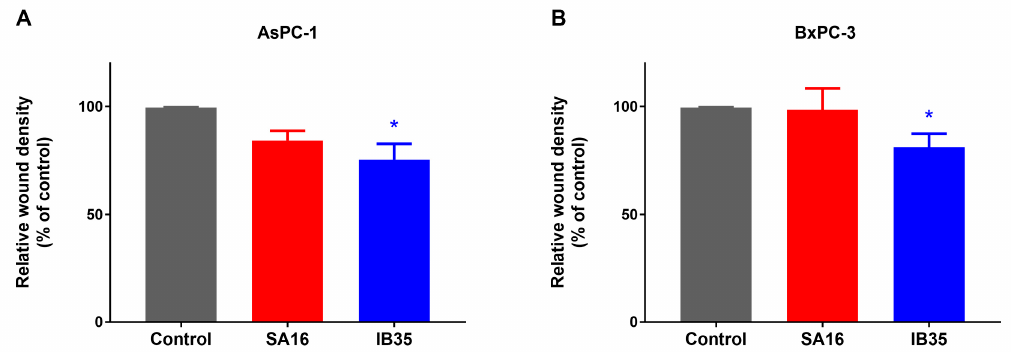
Figure 3. Cell migration of AsPC-1 ( A ) and BxPC-3 ( B ) cells treated with 10 µ M SA16 and IB35 was assessed by wound healing assay 24 h post-wound. Control cells were treated with vehicle alone (DMSO). Wound density was determined at 24 h post wound using IncuCyte ZOOM ™ assay data (* p < 0.05 versus control, Student’s t test). Data are expressed as percentage of control cells and are means ± SEM of at least n = 3 independent